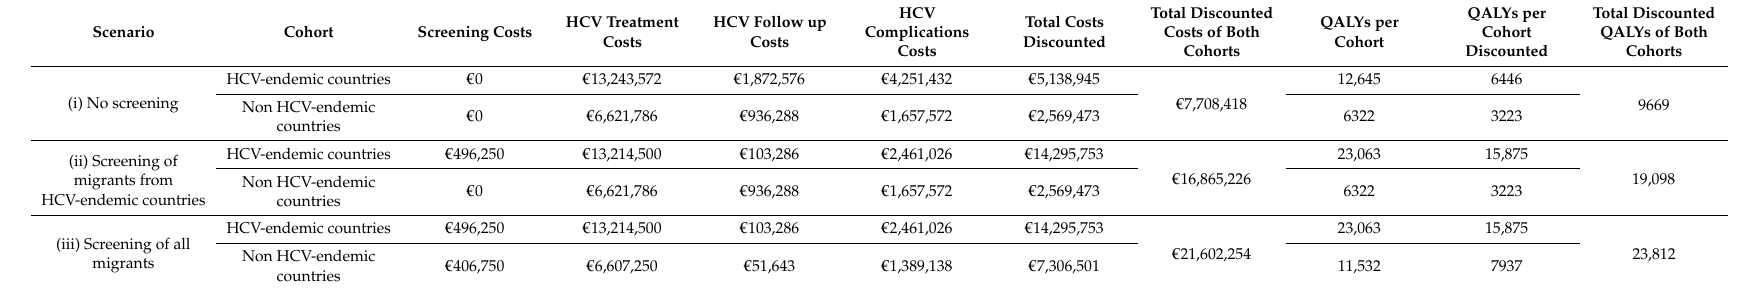
Table 3. The total costs and quality-adjusted life-years (QALYs) of each HCV screening strategy among